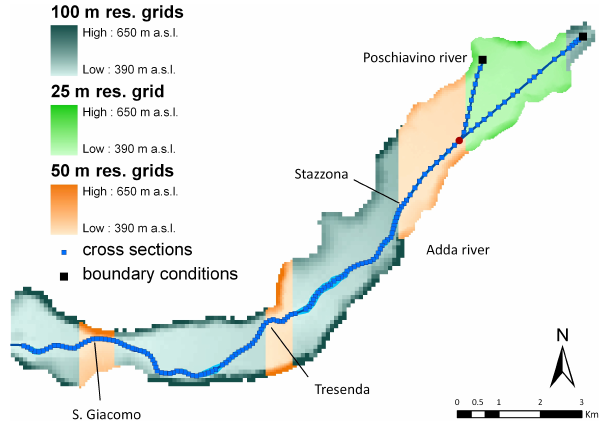
Fig. 2. Combination of the eight different resolution DEMs within the SOBEK 1-D–2-D modelling scheme including the location of boundary conditions and cross sections.